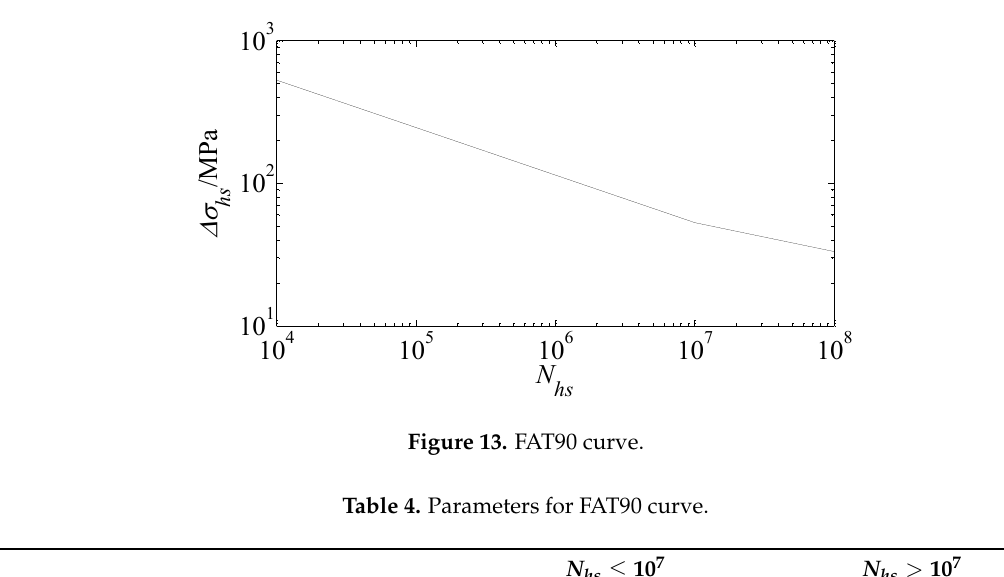
Table 4. Parameters for FAT90 curve.